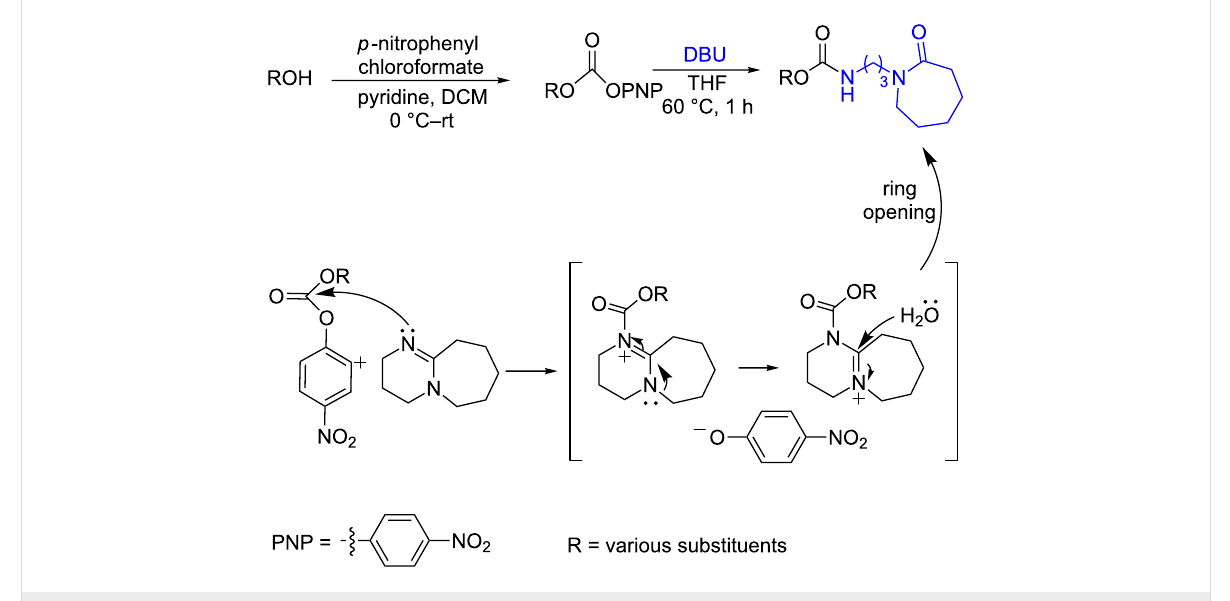
Scheme 1: Reaction of DBU with p -nitrophenyl